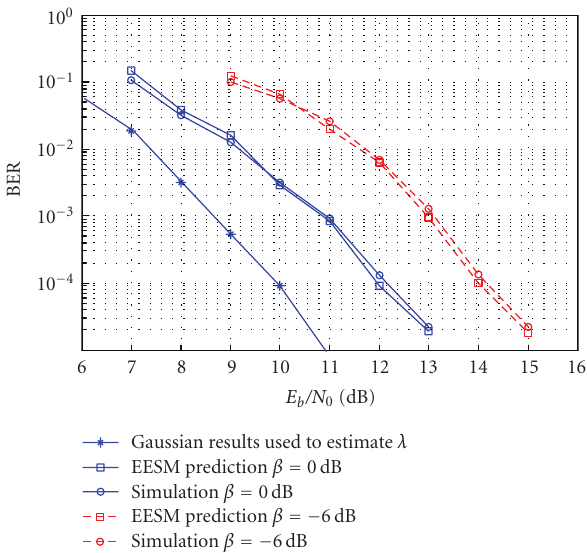
Figure 12: Validation of EESM technique, Golden code scheme, η = 6b/s/Hz, λ = 22 . 6, TU-6 channel.